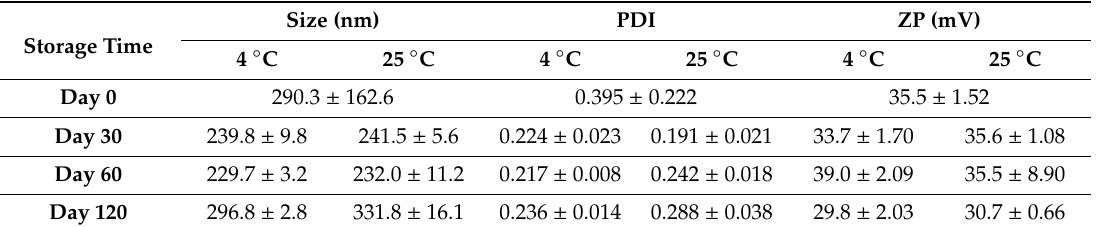
Table 5. E ff ect of storage on particle size, PDI, and ZP of 5 mg loaded CSNPs for 30, 60, and 120 days at 4 ◦ C and 25 ◦ C.